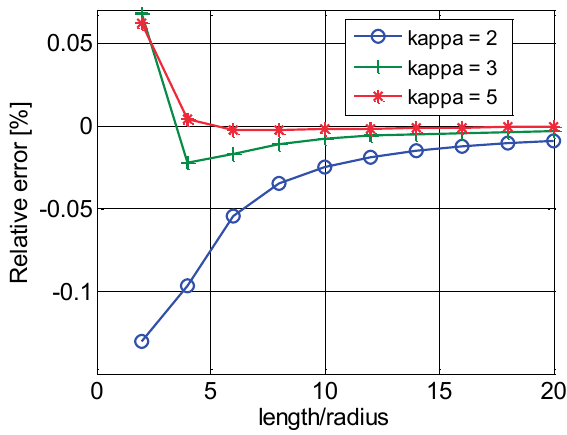
Figure 14: Relative error of formulae (62) and (64) of the Taylor series method.